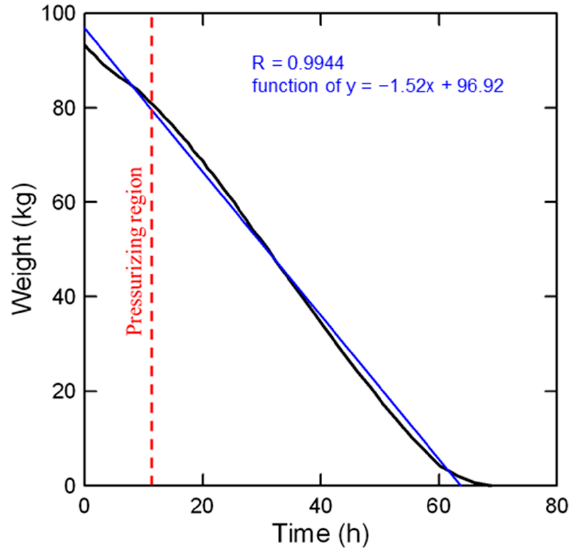
Figure 8. Time dependent liquid nitrogen weight.